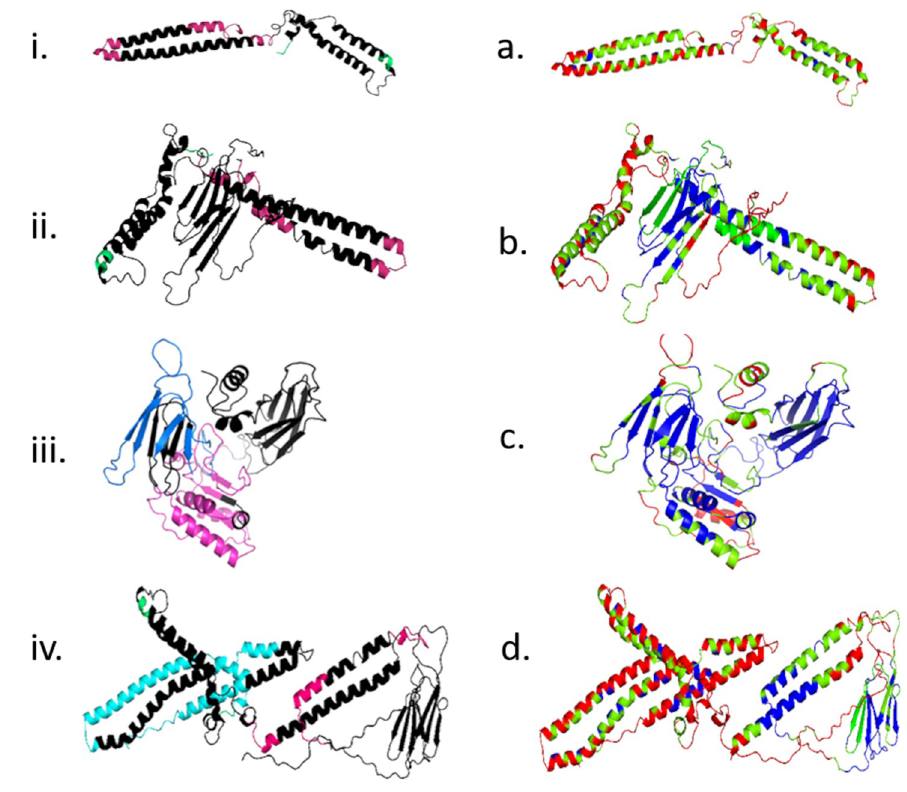
Fig 2. Structural analyses of the fusion antigens bifu25, trifu37, trifu44 and tetrafu56. T-cell epitopes in the 3D molecular structures (i-iv) are shown in black. CPORT analysis (a-d) shows the epitope regions as red, green or blue color, representing active, supporting or non-supporting residues, respectively for cellular